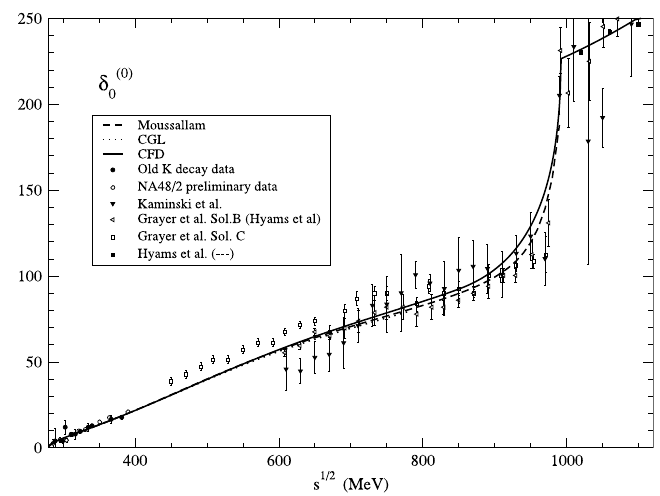
Figure 9. We show the central values of Roy-like analysis following the "Solve" ("CGL" stands for [12] and "Moussallam" for [19]) versus the "Data driven" [8] approaches described in the text. They are fairly consistent, particularly since we have not plotted their associated uncertainty bands to make all curves visible. Figure taken from [2].